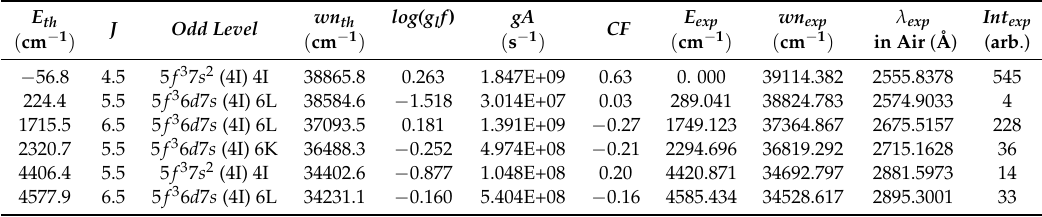
Table 10. Transitions establishing the newly determined even parity level 5 f 3 6 d 7 p ( 4 I ) 6 K ( J = 5.5 ) of the U + ion at 39113.98 ± 0.1 cm − 1 . In log(g l f) , f is the absorption oscillator strength and g l , the statistical weight of the lower level. gA is the upper level statistical weight g multiplied by the Einstein coefficient of spontaneous emission. CF is the cancellation factor defined by Equation (14.107), p432 in